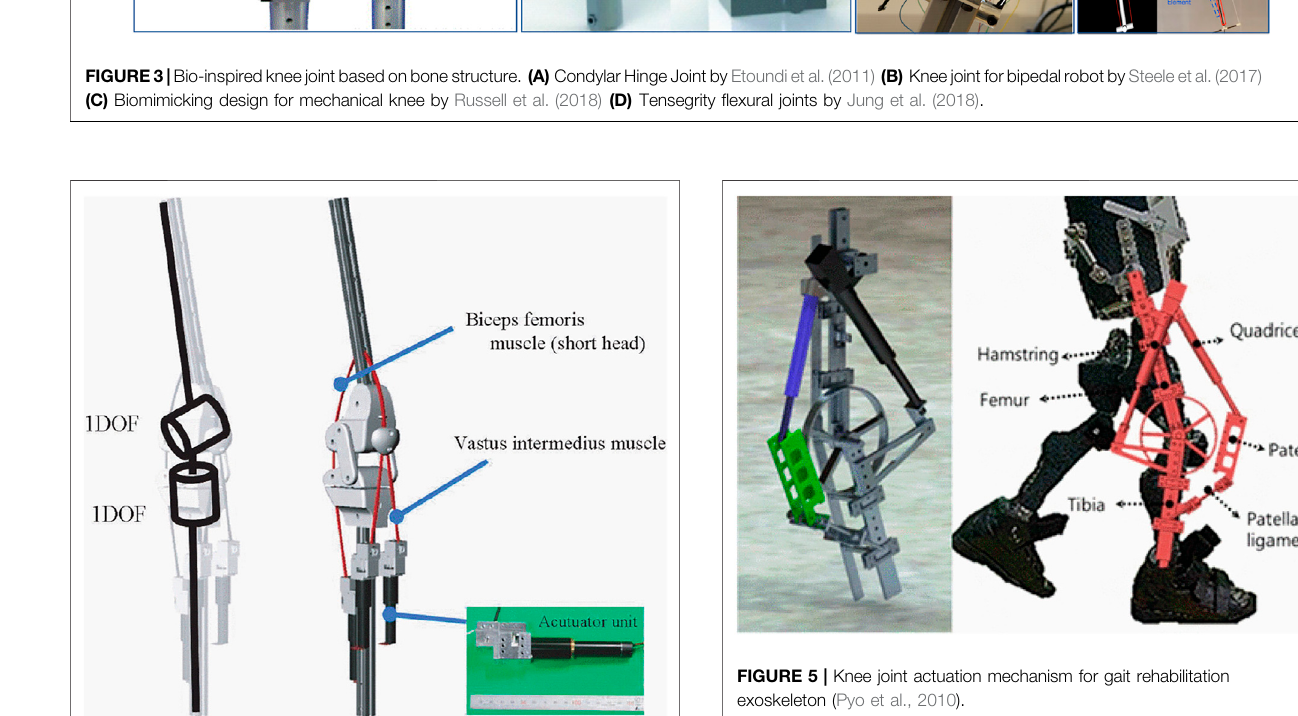
Frontiers in Robotics and AI |